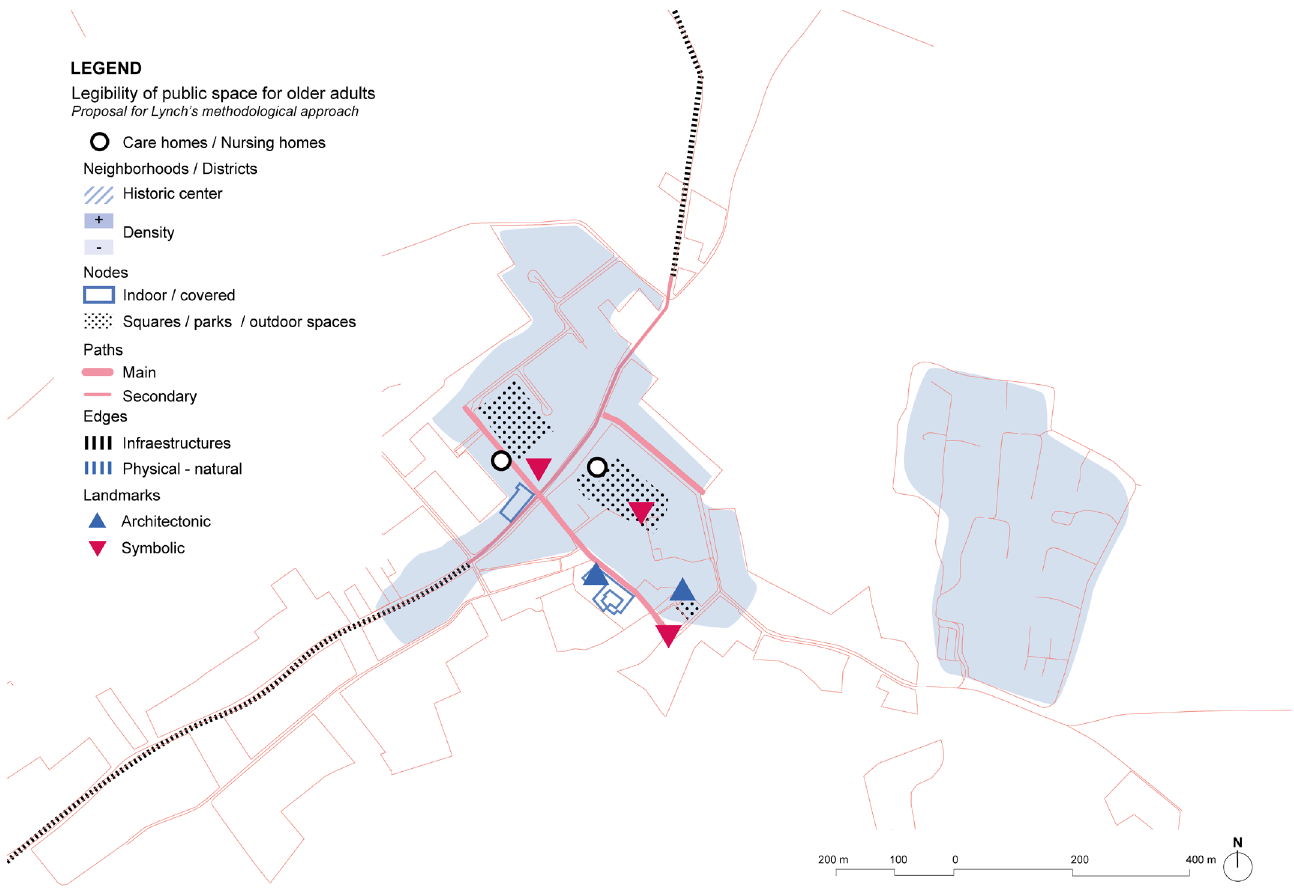
Figure 19. Huis Perrekes center in the town of Osterloo and its surroundings’ scheme based on Lynch’s theory. Source: Own elaboration.